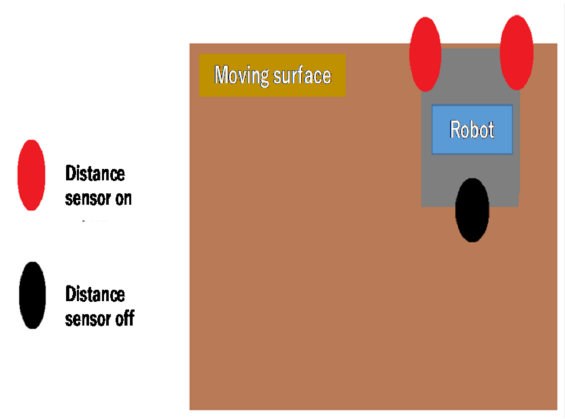
Figure 6. Distance sensor ON and